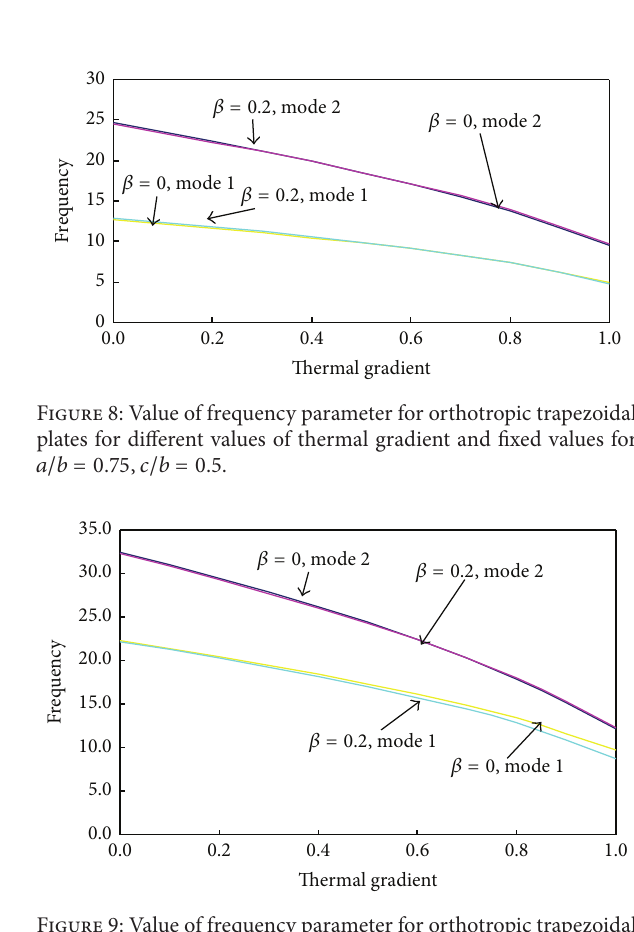
Figure 9: Value of frequency parameter for orthotropic trapezoidal plates for different values of thermal gradient and fixed values for 𝑎/𝑏 = 0.75 , 𝑐/𝑏 = 0.25 . increases for both modes except for the case 𝑎/𝑏 = .75 with 𝑐/𝑏 = .25